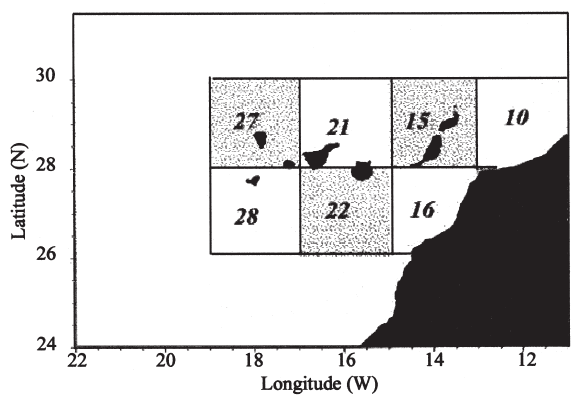
F IG . 1. – Partition of the Canary Archipielago region in 2x2º boxes.